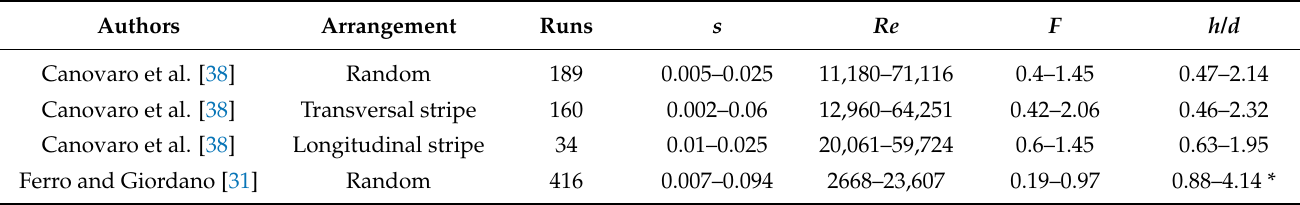
Figure 1. Planimetric view of “Random” ( a ), “Transversal stripe” ( b ), and “Longitudinal stripe” ( c ) arrangements investigated by Canovaro et al. [38]. Table 1. Characteristic data of the investigated experimental runs.